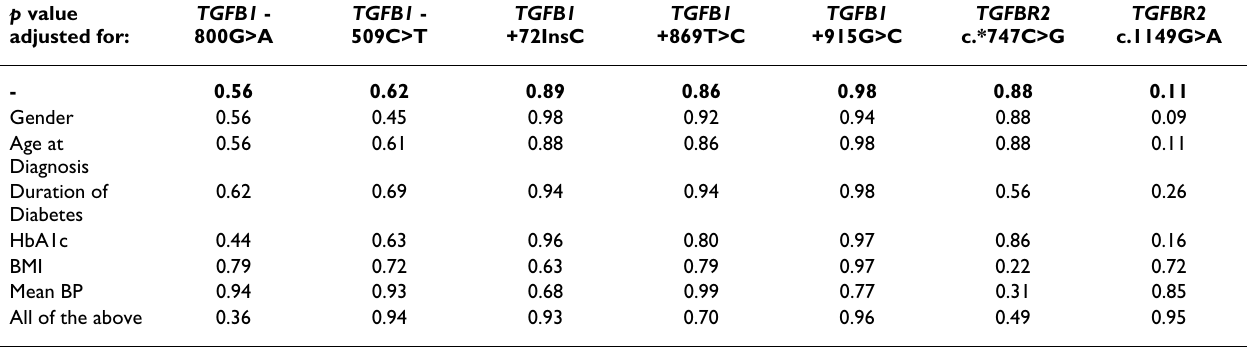
Table 8: Significance values following logistic regression analyses adjusting the association between diabetic nephropathy status and genotype for the listed potential confounders. p value adjusted